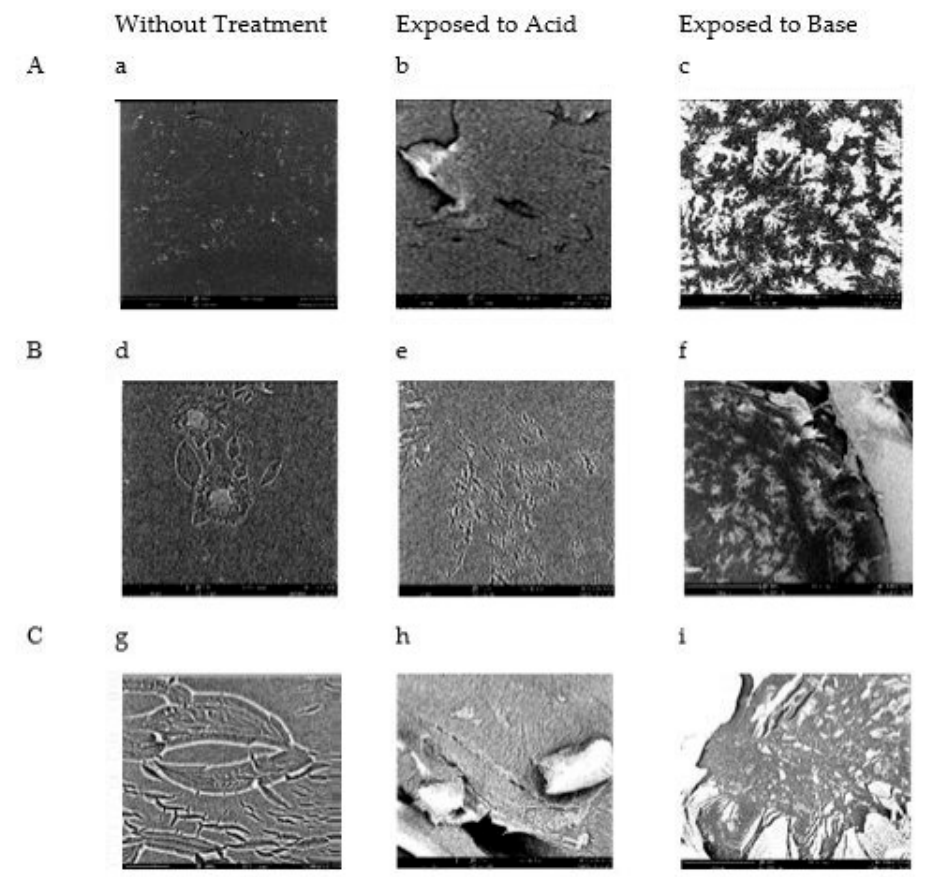
Figure 3. Comparative SEM images of polymers ( A – C ) that have been air dried ( a , d , g ), exposed to 0.1 M HCl (pH 1.1) solution ( b , e , h ), and exposed to 0.1 M NaOH (pH 12.6) solution ( c , f , i ).